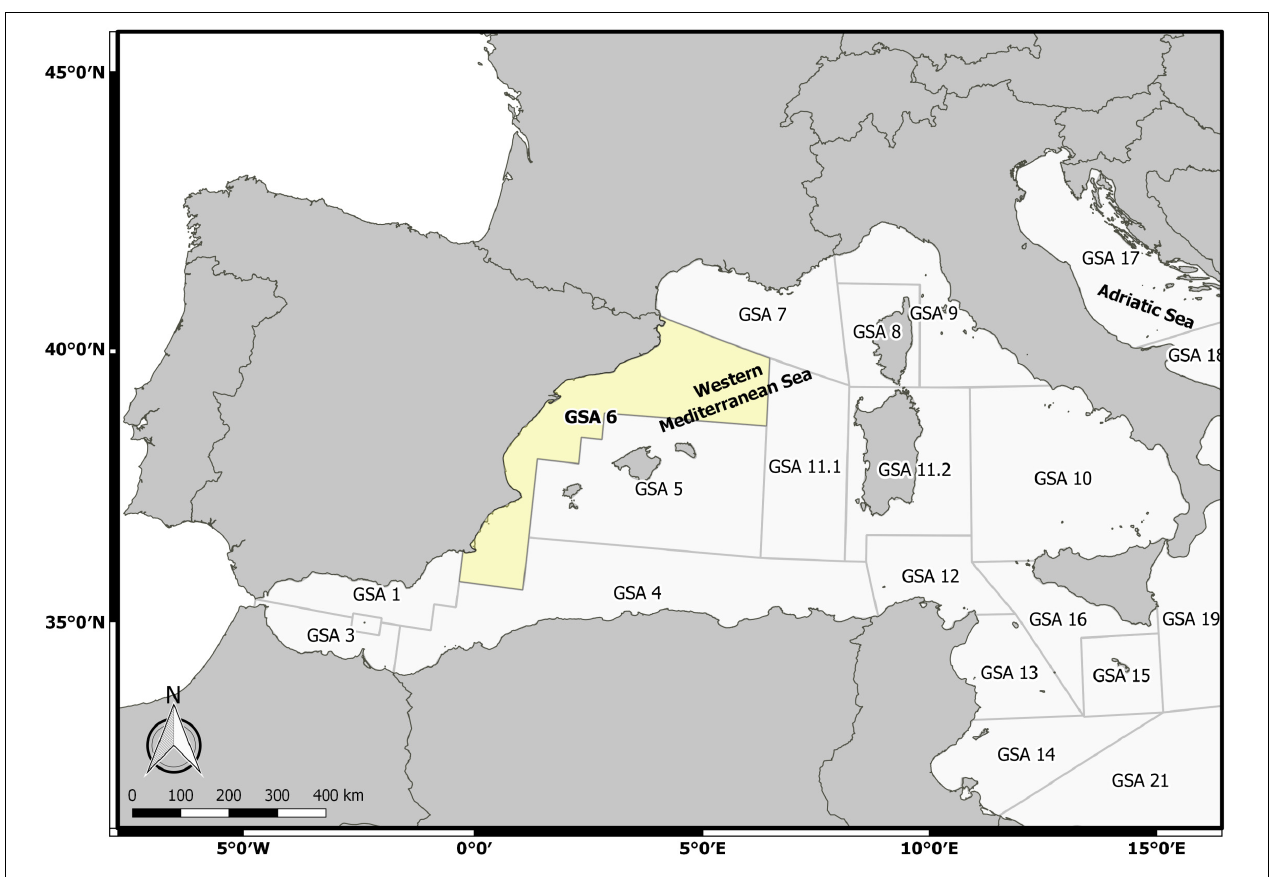
FIGURE 1 | GFCM division areas, including the GSA06 area of this study (coordinates obtained from http://www.fao.org/gfcm/en/). TABLE 1 | Composition and fishing effort capacity of the Mediterranean demersal fisheries fleet of GSA06 in 2015 (from https://ec.europa.eu/fisheries/ cfp/fishing_rules/fishing_fleet_en). Demersal fleet Number of Average Declared Average Gross Average days vessels Power Tonnage at sea* (HP/vessel) (GT/vessel) (day/vessel) Bottom trawl (OTB) 485 196.1 59.9 215 Bottom longline (HOK) 64 75.0 9.2 175 Fixed nets (GNS) 833 39.8 4.9